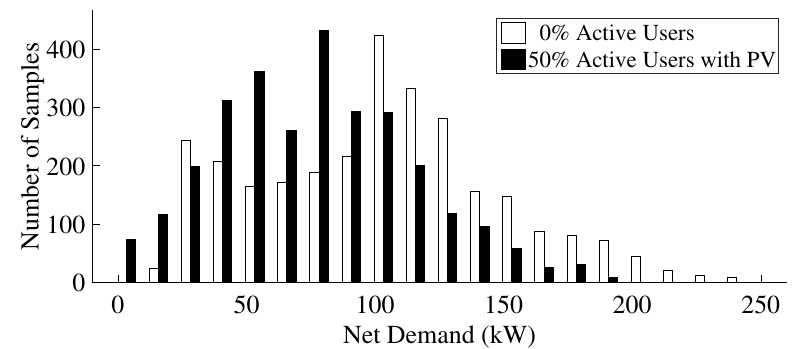
Figure 15. E net for the 25% active customers with PV. k